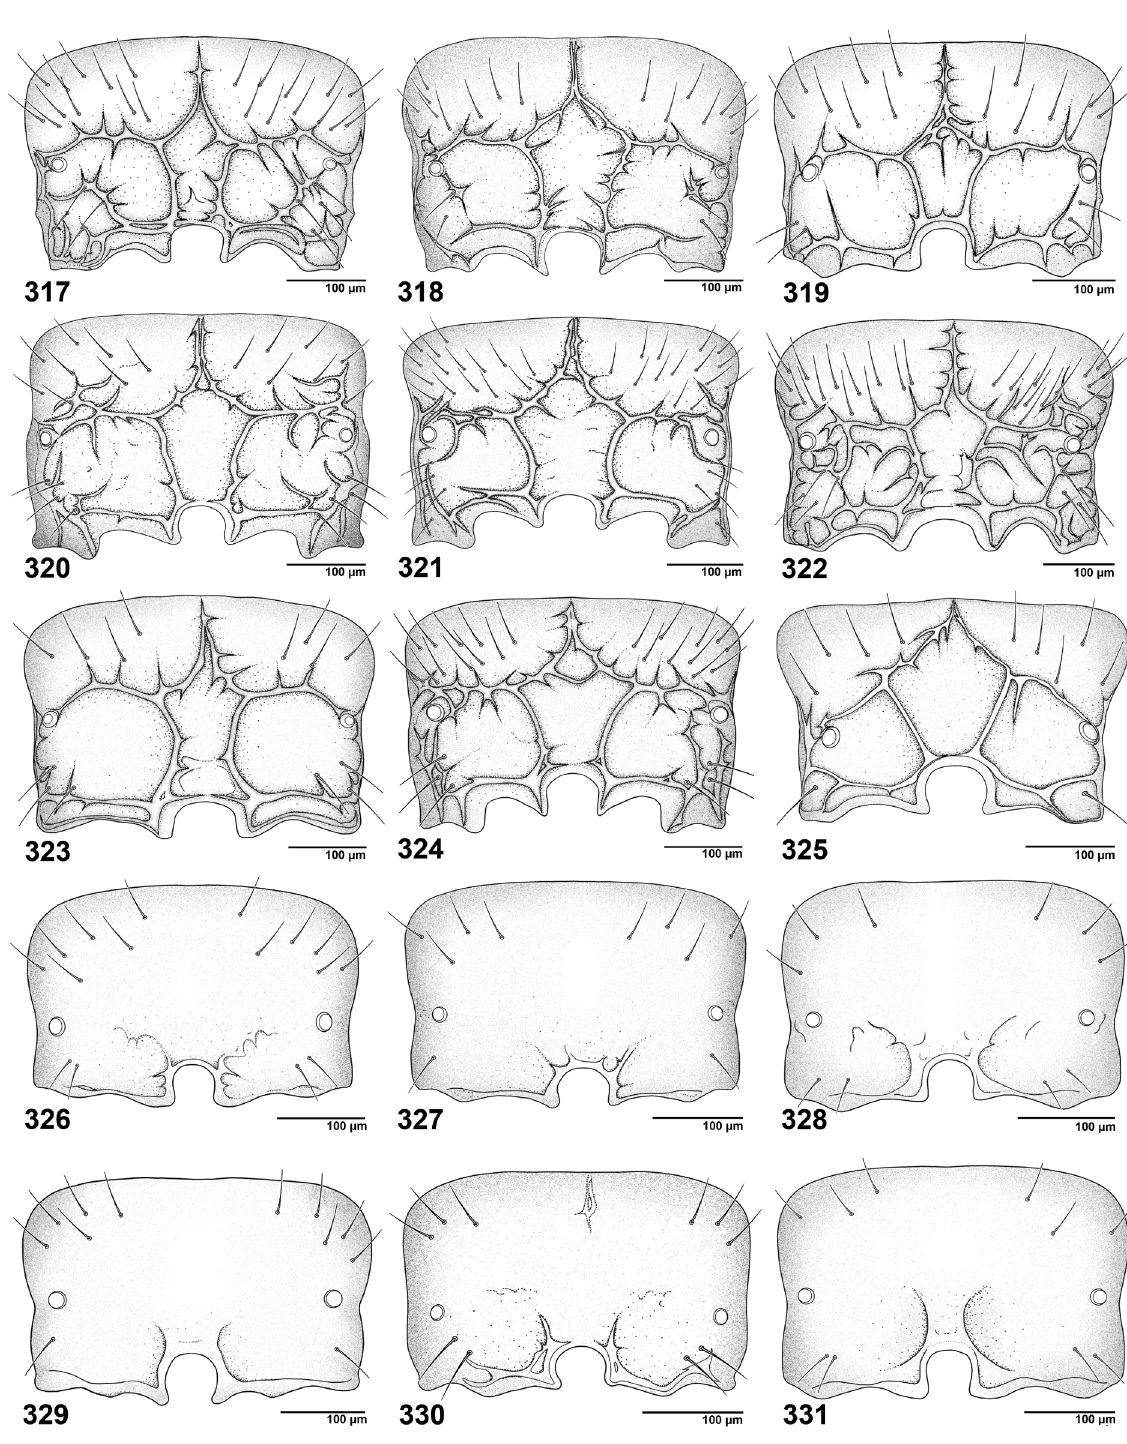
Figs 317–331. Dorsal aspect of propodeum (♀): 317 . Ephedrus cerasicola . 318 . Ephedrus chaitophori . 319 . Ephedrus helleni . 320 . Ephedrus lacertosus . 321 . Ephedrus nacheri . 322 . Ephedrus niger . 323 . Ephedrus persicae . 324 . Ephedrus plagiator . 325 . Lipolexis gracilis . 326 . Lysiphlebus cardui . 327 . Lysiphlebus confusus . 328 . Lysiphlebus desertorum . 329 . Lysiphlebus fabarum . 330 . Lysiphlebus fritzmuelleri . 331 . Lysiphlebus